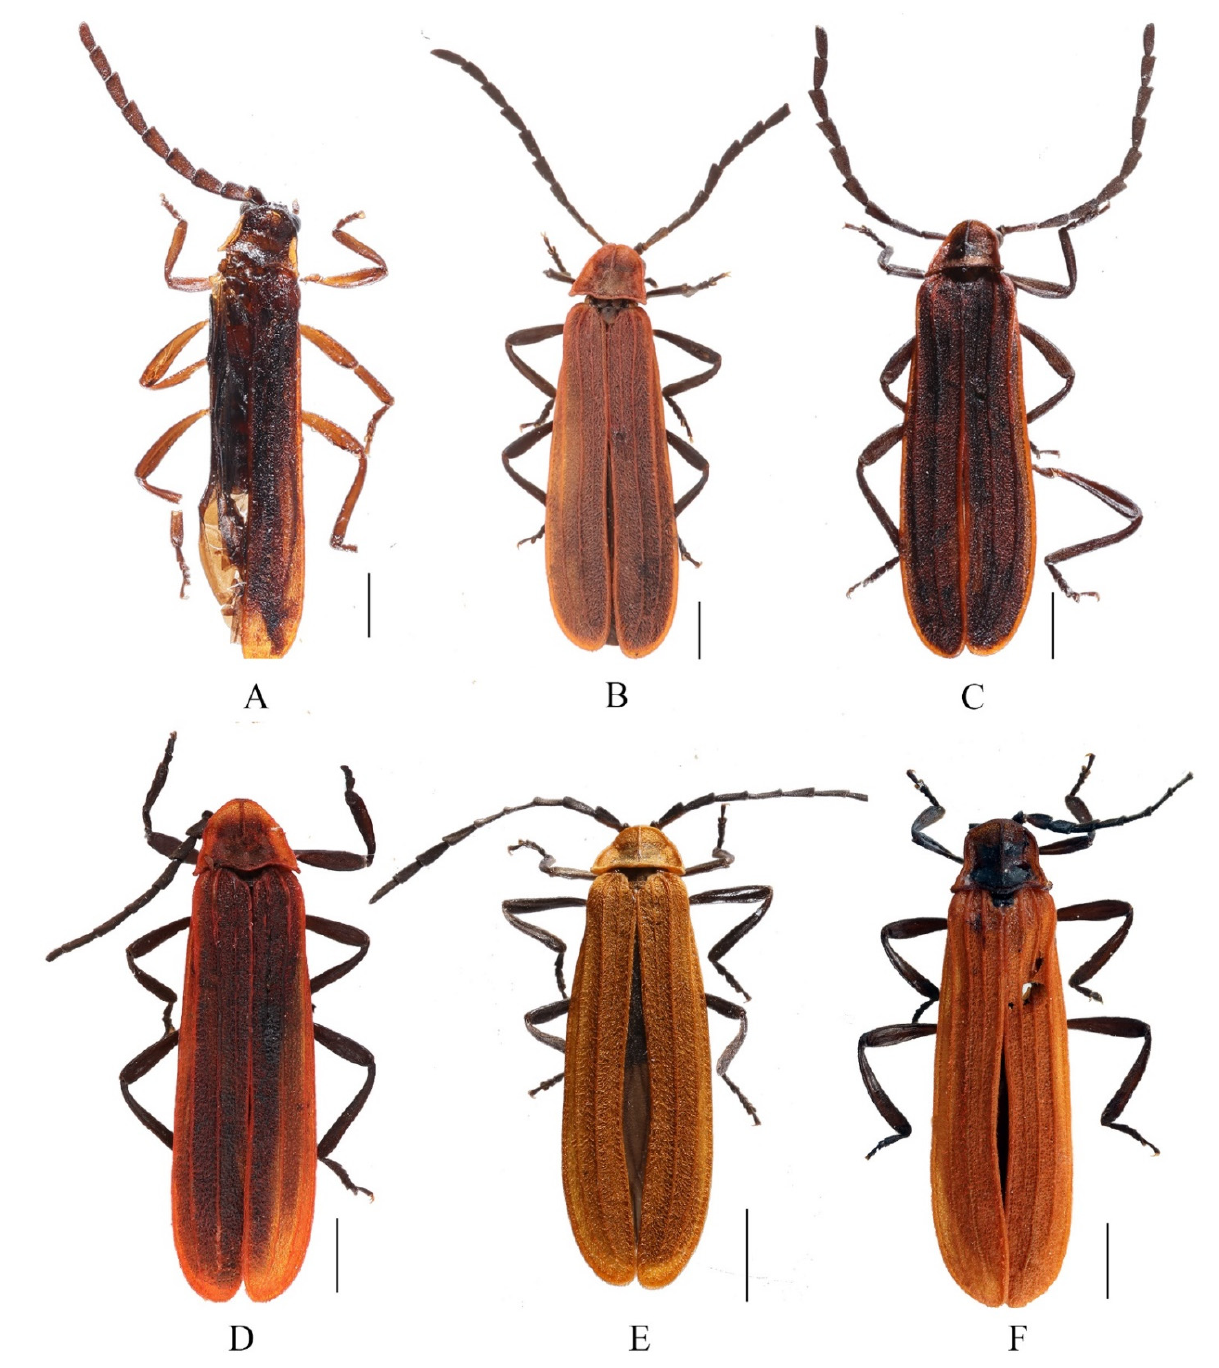
Figure 2. Male habitus of Mesolycus species: ( A ). M. dentatus sp. n.; ( B ). M. qinlinganus (Kazantsev, 2000); ( C ). M. shaanxiensis sp. n.; ( D ). M. varus sp. n.; ( E ). M. breviplatus sp. n.; ( F ). M. murzini Kazantsev, 2004. Scales: 1.0 mm. Pronotum trapezoidal, 0.7 times as long as wide, disc present with a median longitu- dinal keel extending from anterior margin to middle part. Anterior margin round, lateral margins diverging posteriorly, posterior margin bisinuate; anterior angles confluent with anterior margin and posterior angles sharply projecting. Scutellum trapezoidal, feebly emarginate at